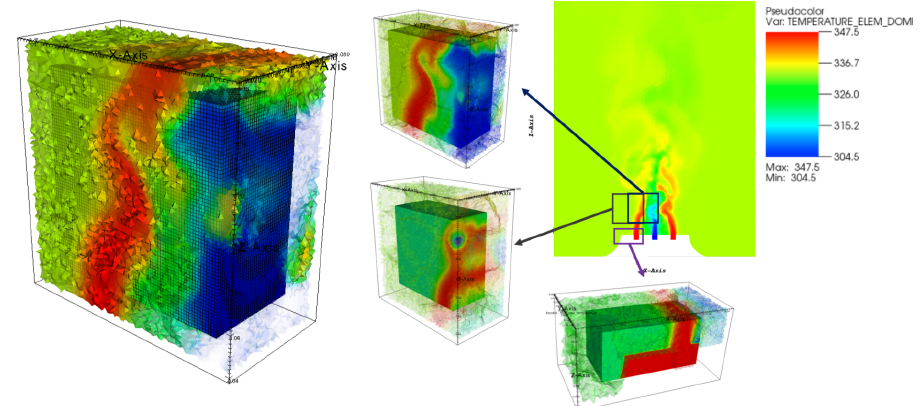
Figure 6. Examples of some interpolations of temperature fields from a tetrahedral mesh to a hexahedral mesh using the MEDCoupling pre-/postprocessing library.